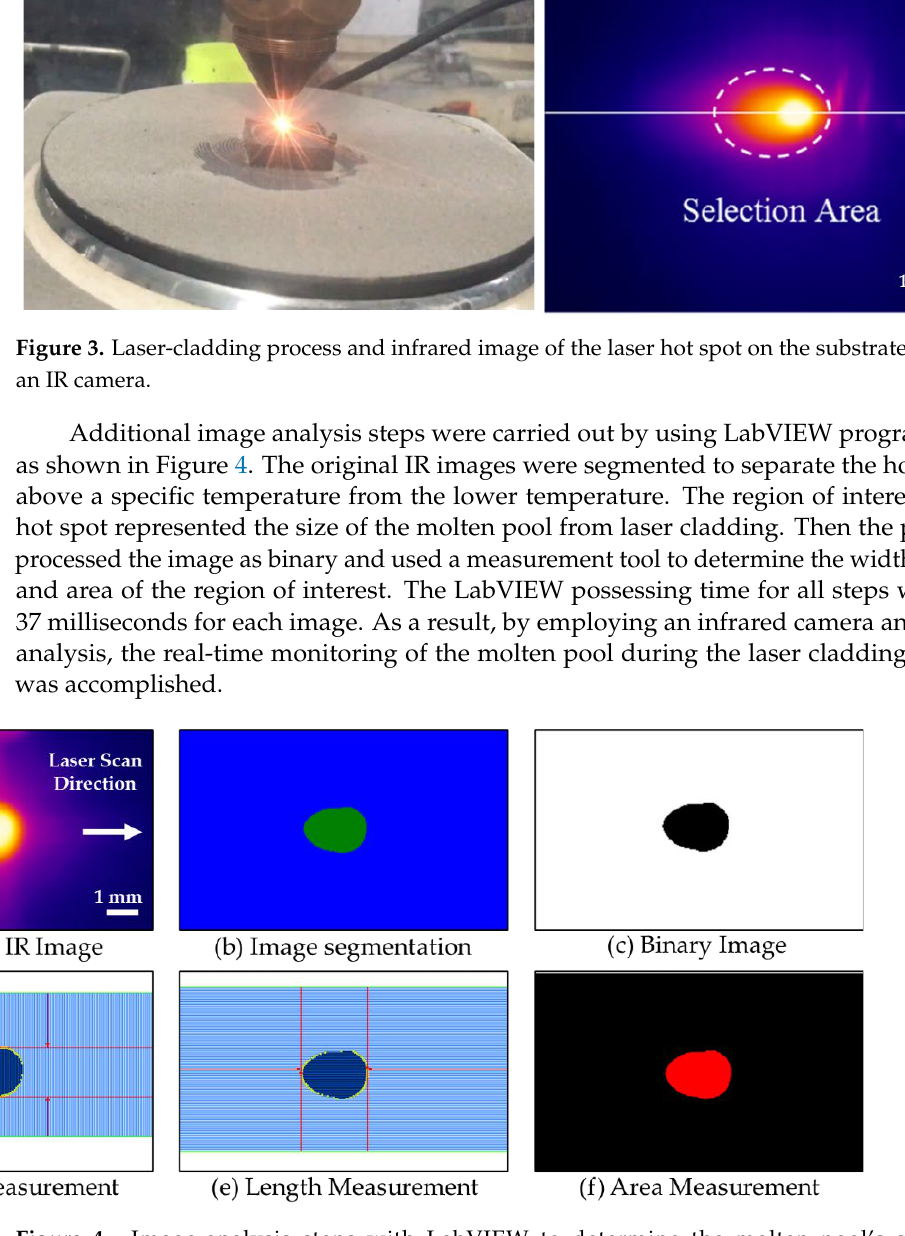
Figure 4. Image-analysis steps with LabVIEW to determine the molten pool’s size from infrared image.